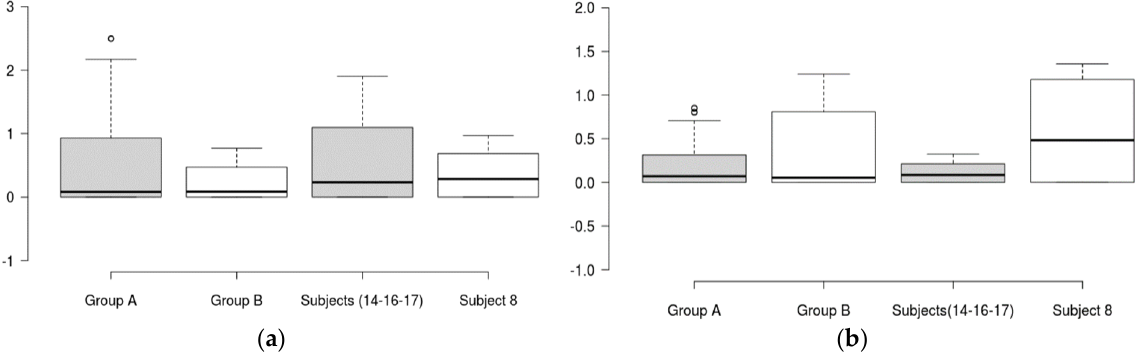
Figure 5. Box plot to see the distribution of raw EMG values for NP task in Session 3: ( a ) distribution of RBC muscle values of NP task in Session 3 ( b ) distribution of RFCR muscle values NP task in Session 3.